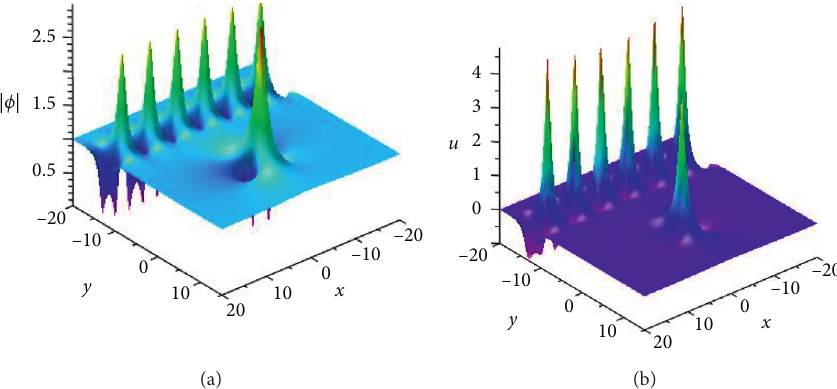
Figure 10: Semirational solutions | ϕ | and u consisting of a lump and one breather for the nonlocal Mel ′ nikov equation with parameters